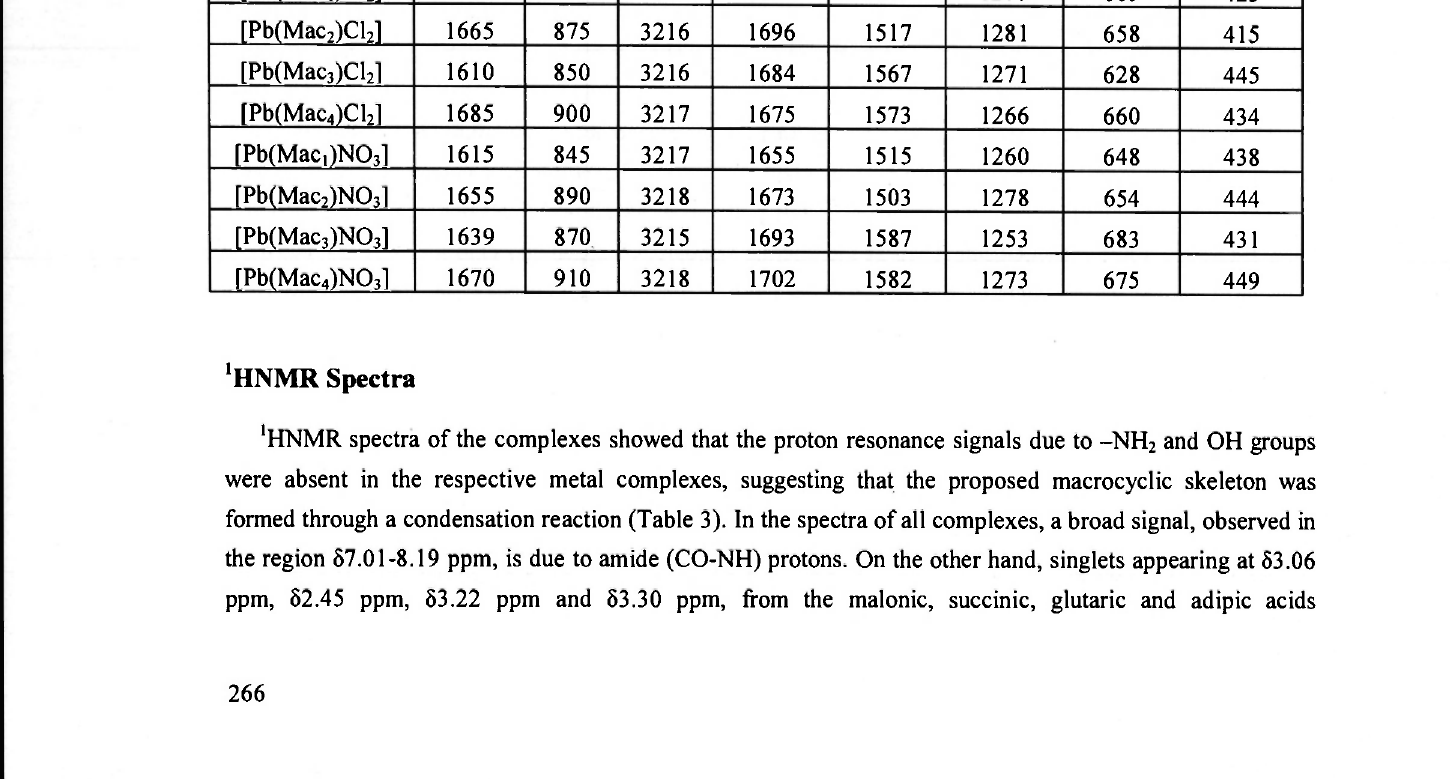
IR Spectral Data (in cm" 1 ) of Macrocyclic Complexes of Lead